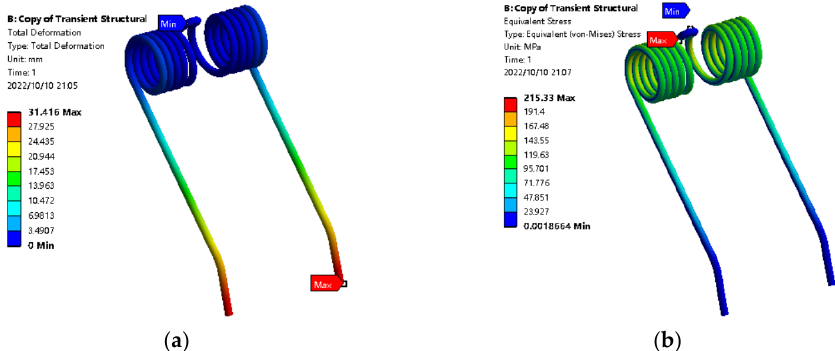
Figure 15. The analysis results. ( a ) Hook tooth deformation cloud map; ( b ) Hook tooth stress